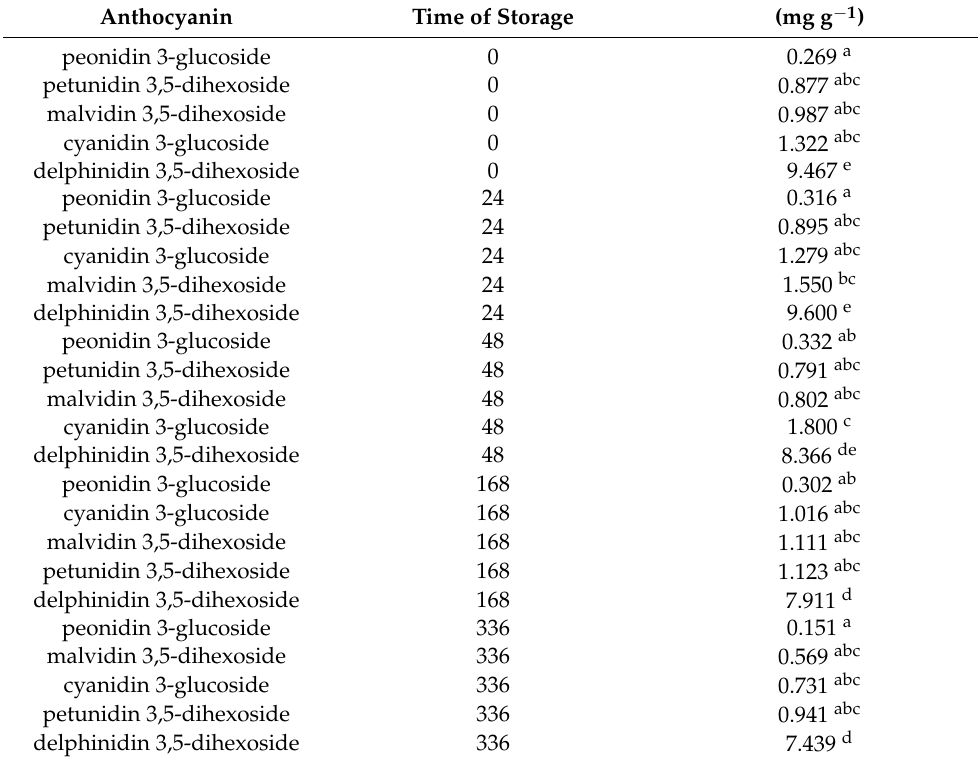
Table 3. Evaluation of the stability of anthocyanins encapsulated by spray drying over 336 days of storage at 5 ◦